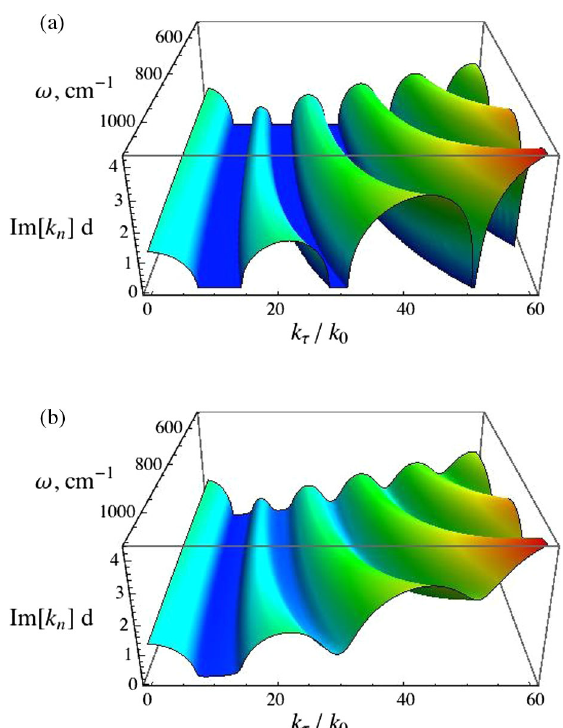
(cid:2) d vs n Ga 0 As Al 0 In 0 As = In 0 Ga 0 As . 53 . 47 . 48 . 52 . 53 . 47